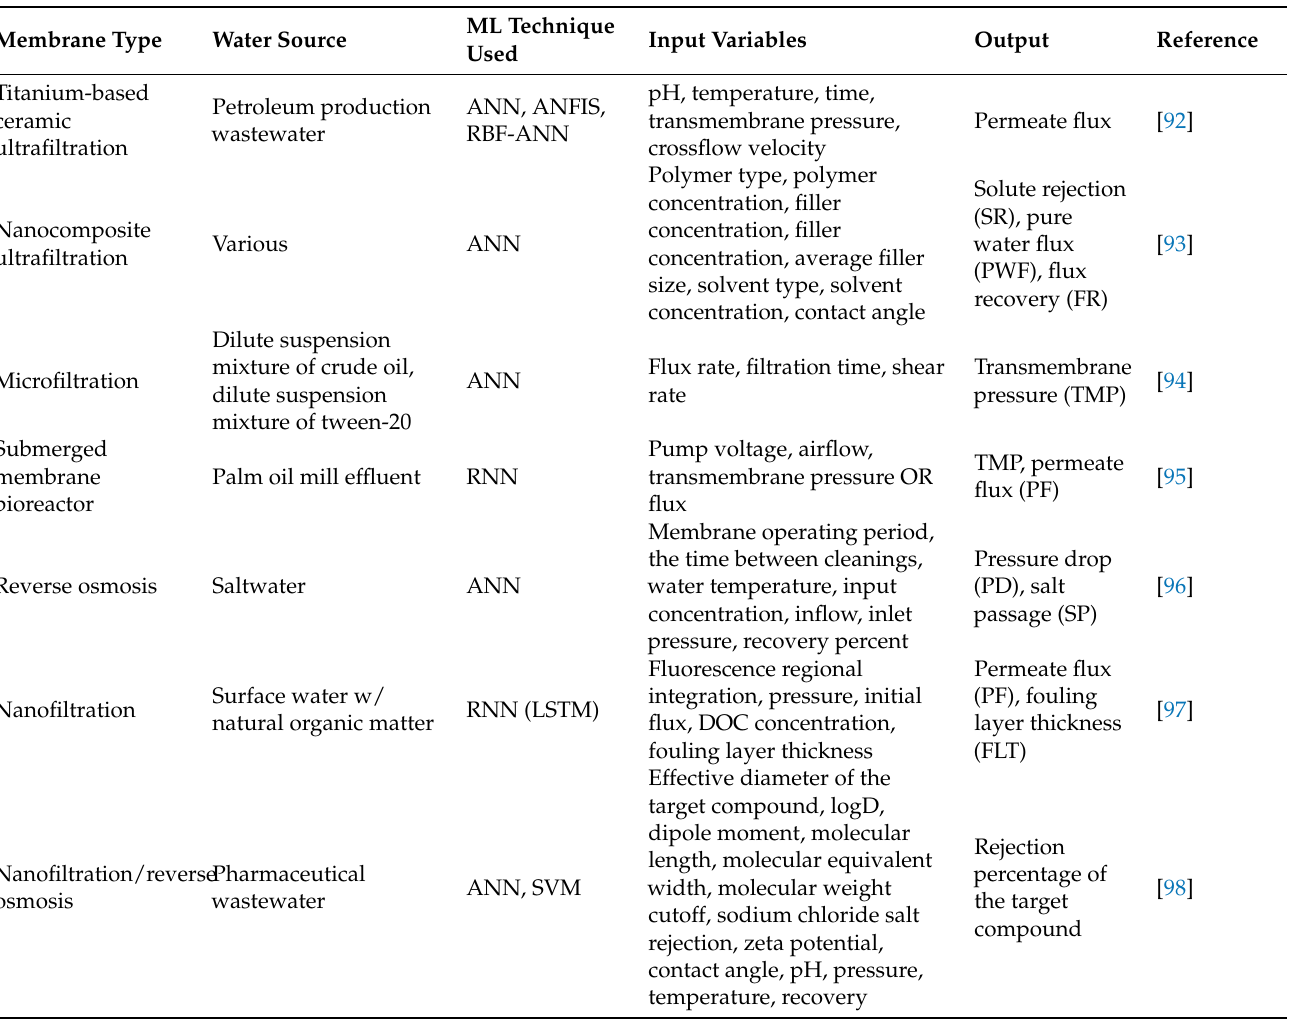
Table 4. ML to model and predict membrane-filtration